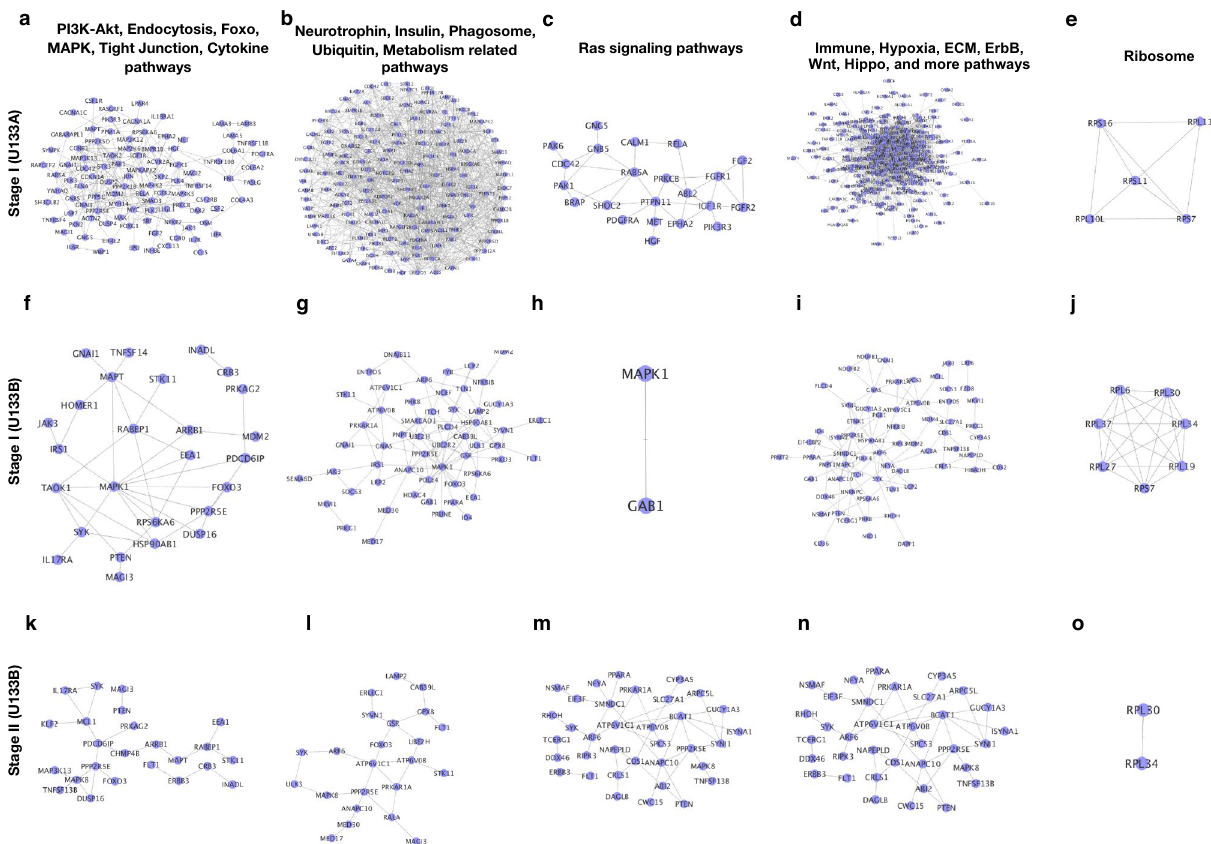
Figure 2. Networks for the genes matched with those pathways which are enriched (p-values ≤ 0.001) and common shown in venn diagram for all the four DEGs list (Stage I and II for U133A and U1333B). In this figure, we have selected those pathways which are commonly enriched pathways and mapped the genes belonging to these pathways from the DEGs list and finally mapped out the networks. ( a – e ) It represents the networks for Stage I of U133A platform data for the list of pathways. ( f – j ) It represents the networks for Stage I of U133B platform data for the list of pathways. ( k – o ) It represents the networks for Stage II of U133B platform data for the list of pathways. All these networks, were drawn by using cytoscape